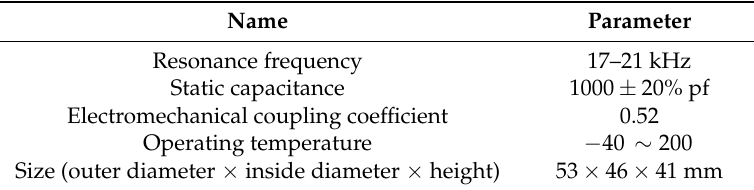
Table 2. Parameters of the piezoceramic transducer.